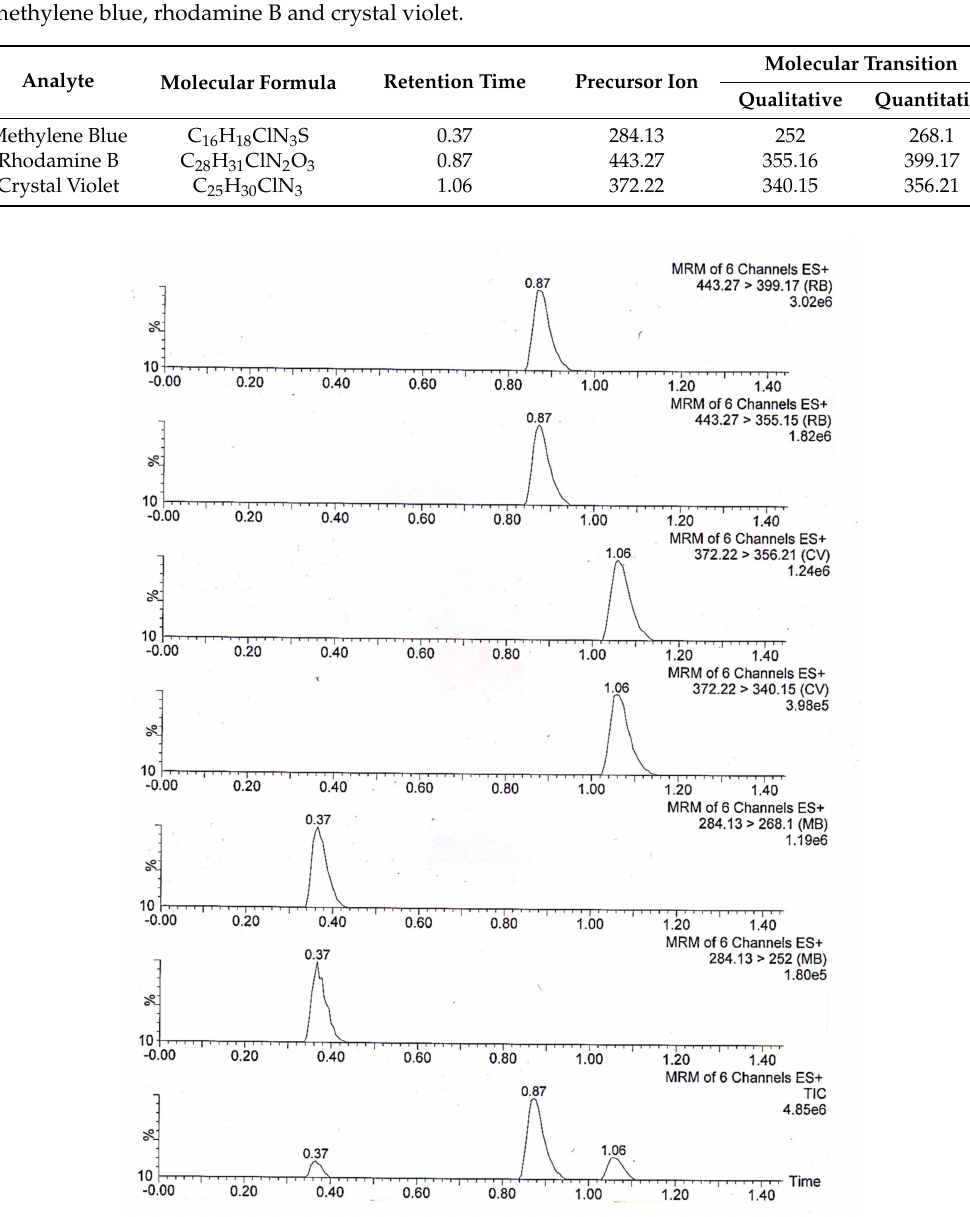
Figure 1. MRM chromatograms of methylene blue, rhodamine B and crystal violet using UPLC-MS /